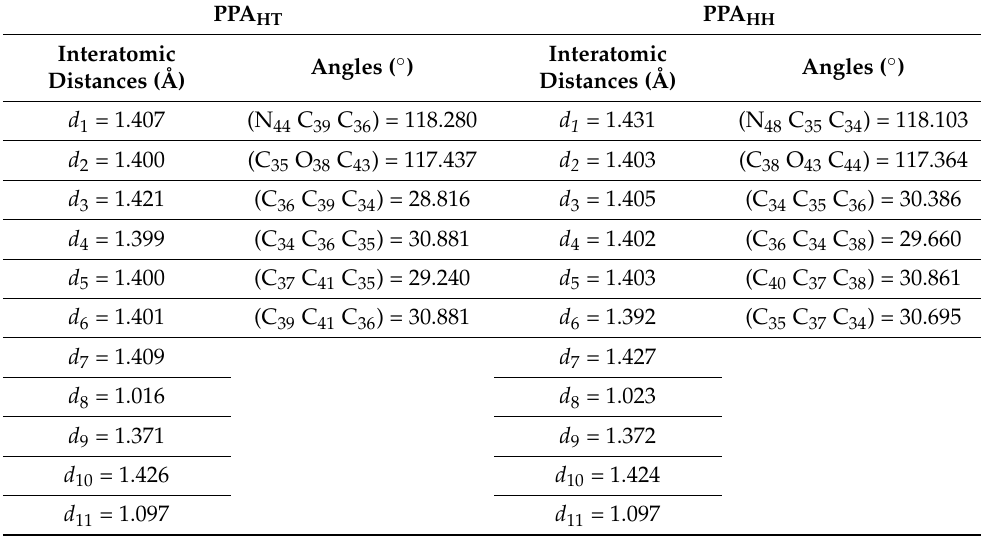
Table 3. Interatomic distances (Å) and angle values observed in PPA HT , Cl–PPA HT , PPA HH , and Cl– PPA HH tetramers.